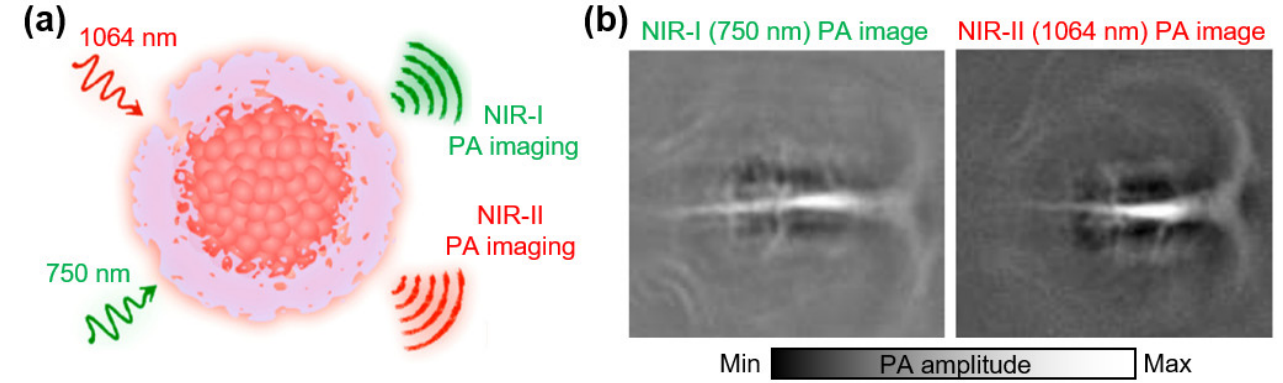
Figure 6. Contrast-enhanced PA images of SNPs in the NIR-II region. ( a ) Schematic illustration of SPNs for broadband PA imaging in NIR-I and NIR-II regions. ( b ) Contrast-enhanced PA images of a rat brain in vivo. PA, photoacoustic; US, ultrasound; SPN, semiconducting polymer nanoparticle; NIR, near-infrared. Reprinted with permission from Ref. [103]. 2017, ACS Publications. Organic dyes have also been found to possess NIR-II-absorbing capability. Zhou et al., reported phosphorous phthalocyanine with an absorption peak at ~1000 nm (Figure 7a)